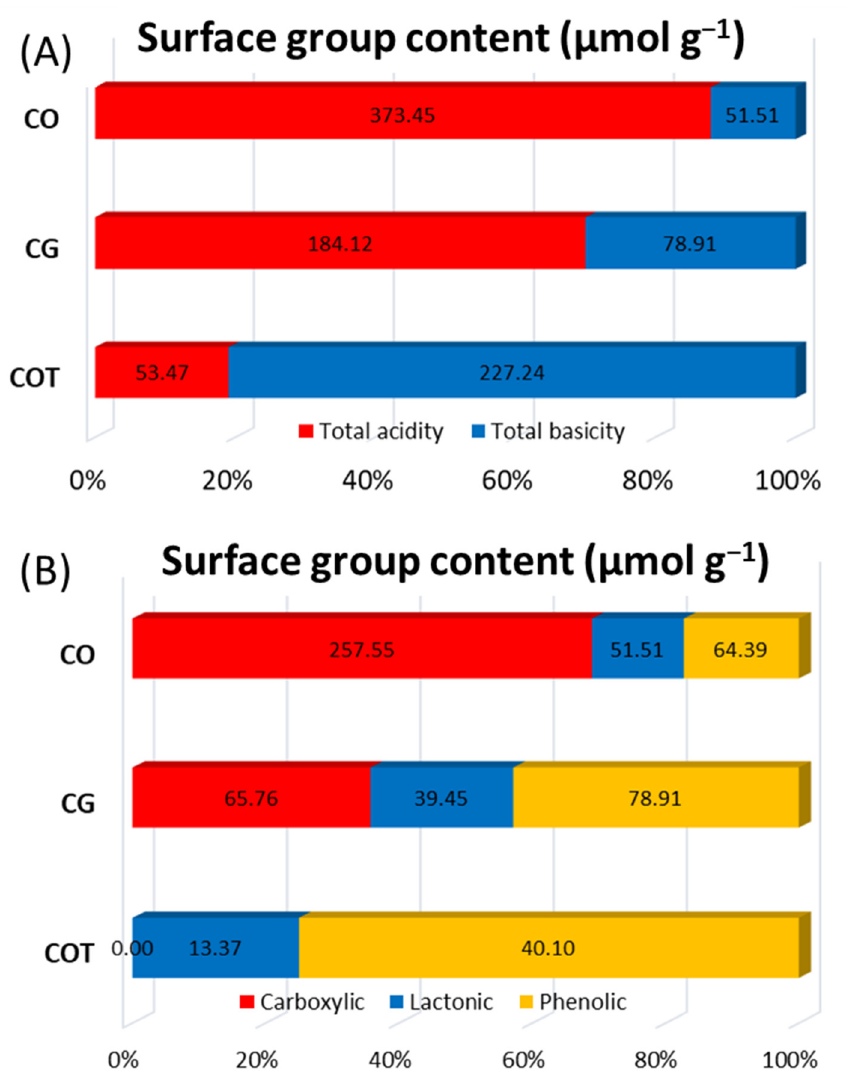
Figure 3. Surface group content for CO, CG and COT. ( A ) Total acidity, total basicity; ( B ) Carboxylic, lactonic and phenolic surface groups.